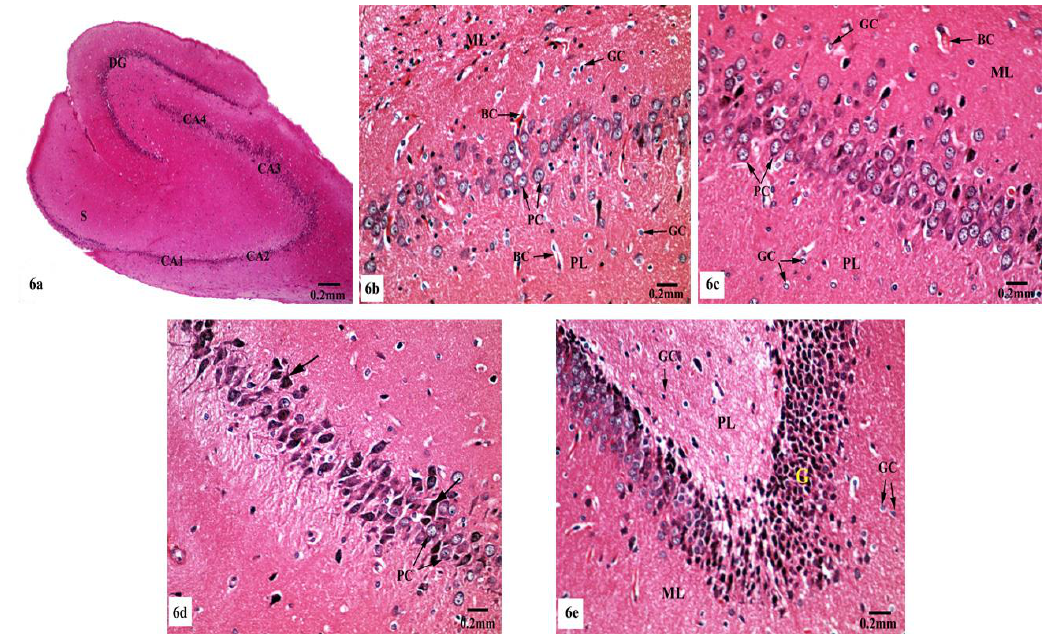
Figure 6. Photomicrographs of the hippocampal tissues of AlCl 3 + SM-treated rats stained with Hx&E showing ( a ) restoration of the laminar organization with preservation of the characteristic structure of the hippocampal tissues: CA1, CA2, CA3, and CA4, DG, and subiculum (S); ( b ) preservation of small pyramidal cells (PC) of the CA1 subfield with normal glial cells (GC) and blood capillaries (BC) in the molecular (ML) and polymorphic (PL) layers; ( c ) the CA3 subfield appeared with nearly normal large pyramidal cells (PC) having vesicular nuclei, additionally intact glial cells (GC) and blood capillaries (BC) were seen; ( d ) another CA3 area revealed large pyramidal cells ( → ) having dark nuclei among normal ones (PC); ( e ) preservation of normal organization of granular cells (G) of the DG with normal glial cells (GC) in both polymorphic (PL) and molecular (ML) layers.